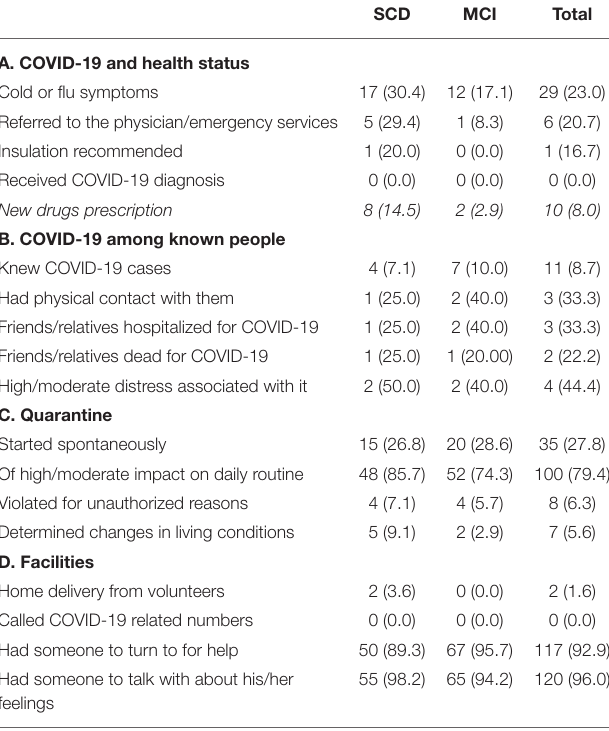
TABLE 2 | Clinical information regarding the health of the participants and their TABLE 1 | Sociodemographic, clinical, cognitive, and functional characteristics of acquaintances, and data concerning the quarantine and facilities available the sample, divided by diagnosis. during SCD MCI Total